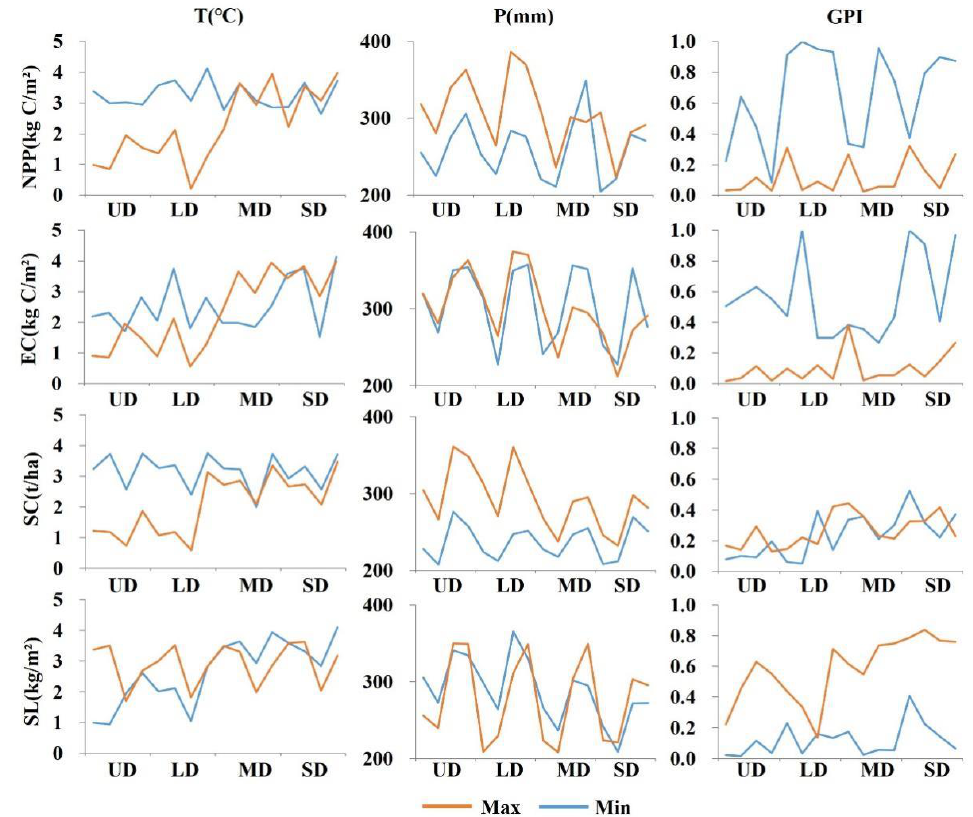
Figure 10. Effects mechanism of climate change and grazing pressure on the relationship between grassland degradation and ecosystem services. T, temperature (°C); P, precipitation (mm); GPI, grazing pressure index; NPP, net primary production (kg C/m 2 ); EC, ecosystem carbon (kg C/m 2 ); SC, soil conservation (t/ha); SL, soil loss by wind (kg/m 2 ).